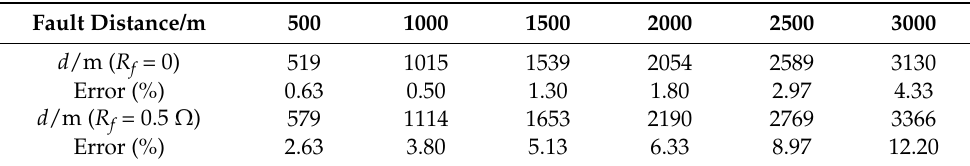
Table 3. Results for the proposed location